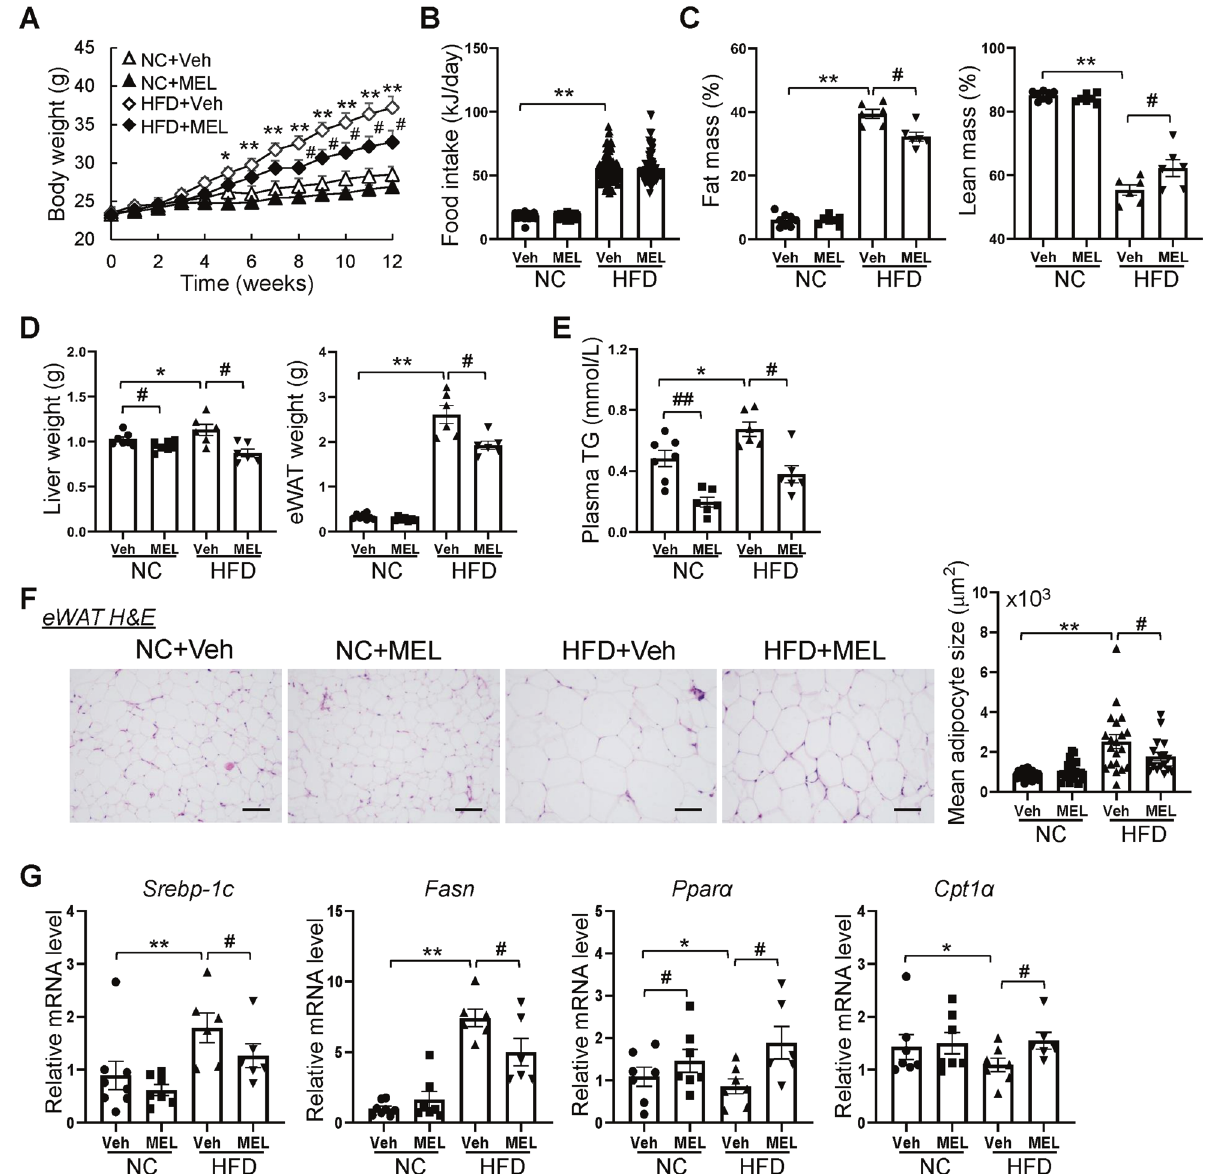
Fig. 1 Melatonin decreases body weight gain and adipocyte hypertrophy in HFD-fed mice. A Body weight of mice. B Food intake of mice. C Fat mass and lean mass of mice. D Liver and eWAT weight of mice. E Plasma triglyceride (TG) content. F H&E-stained eWAT sections. Scale bars = 100 μ m. G mRNA levels of lipogenesis-related and fatty acid oxidation-related genes in eWAT. Data are mean ± SEM, n = 5 – 8. Signi fi cance was determined by one-way ANOVA. *p < 0.05, **p < 0.01 vs. NC + Veh mice; # p < 0.05, ## p < 0.01, vs. HFD + Veh